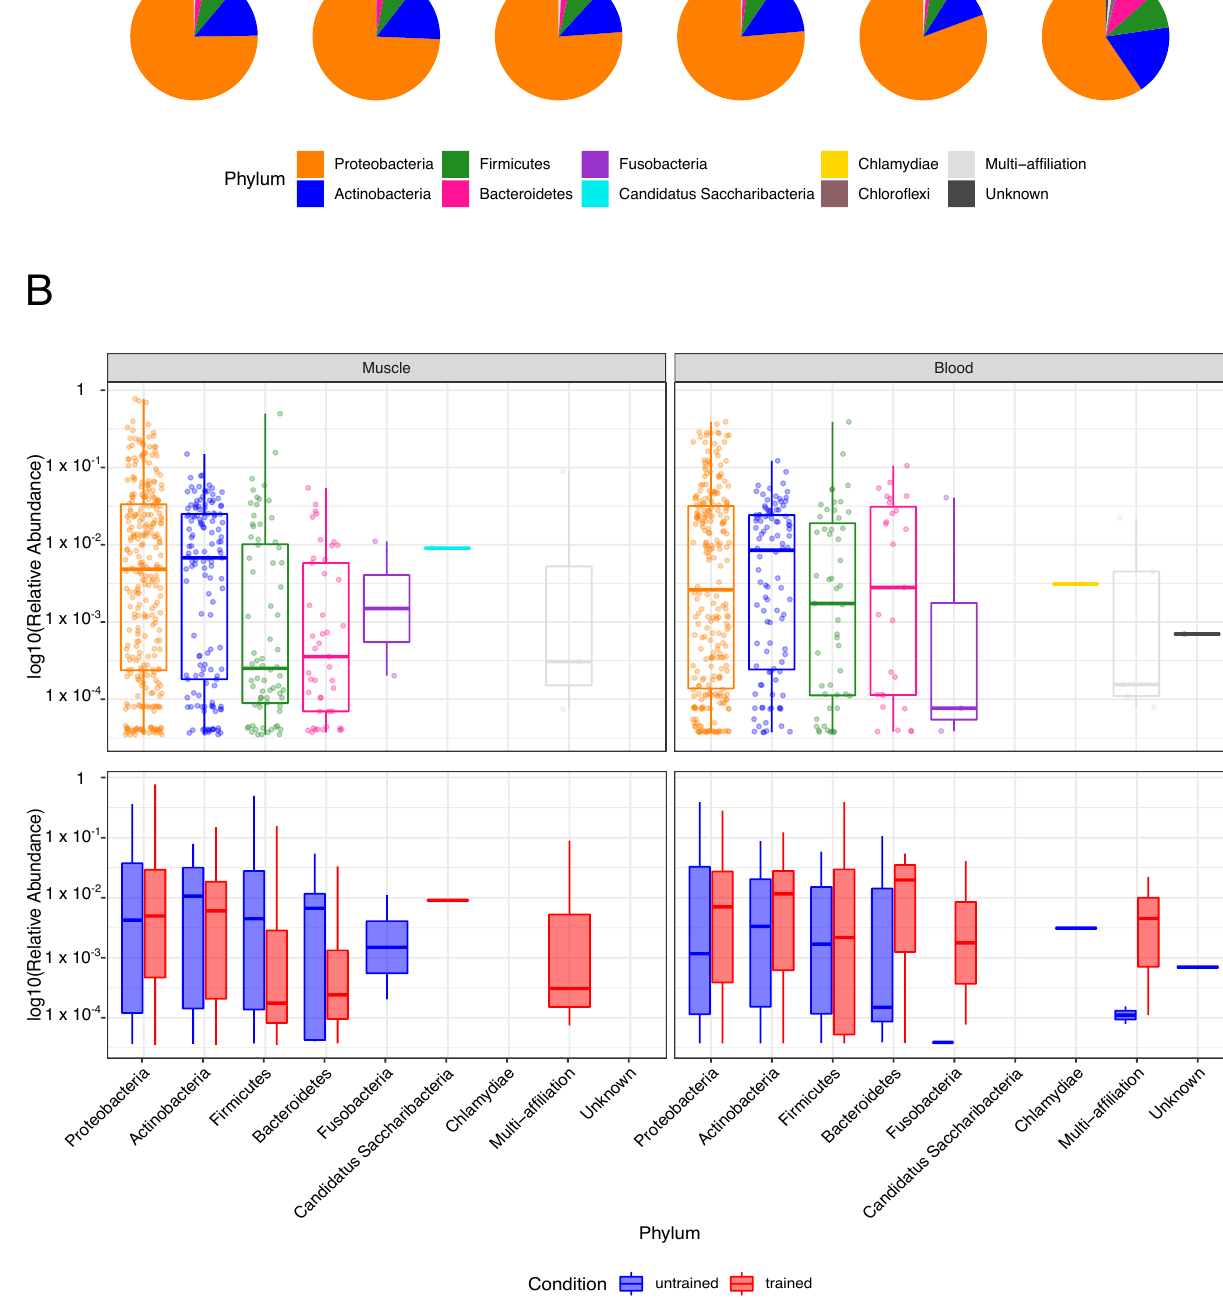
Figure 2. Phyla composition in tissues and controls: ( A ) The pie charts depict the phyla distributions in the entire cohort (whole), samples of untrained and trained participants, muscle and blood samples and negative controls (controls). ( B ) The boxplots display the Log10-transformed, sample-wise relative abundances of operational taxonomic units (OTUs) by phylum for the entire cohort (top) as well as before and after training